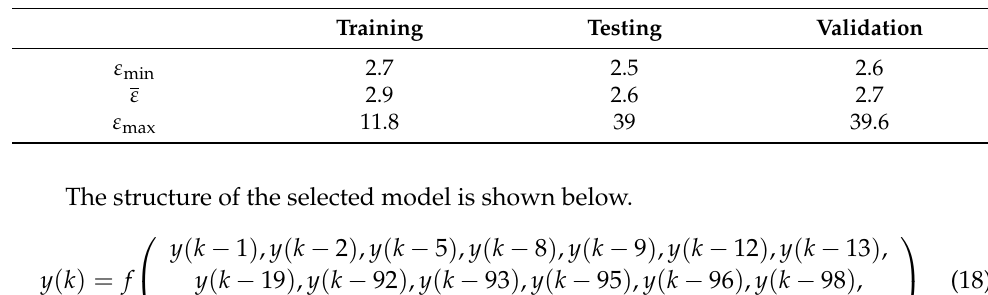
Figure 8. Measured (blue) and one-step-ahead forecast (red) solar irradiance for four selected days.